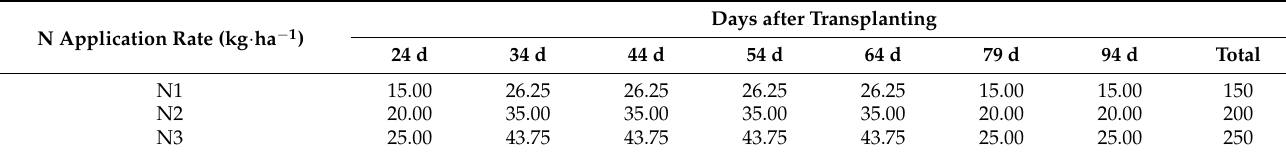
Table 2. Fertilization (kg · ha − 1 ) records over the experimental